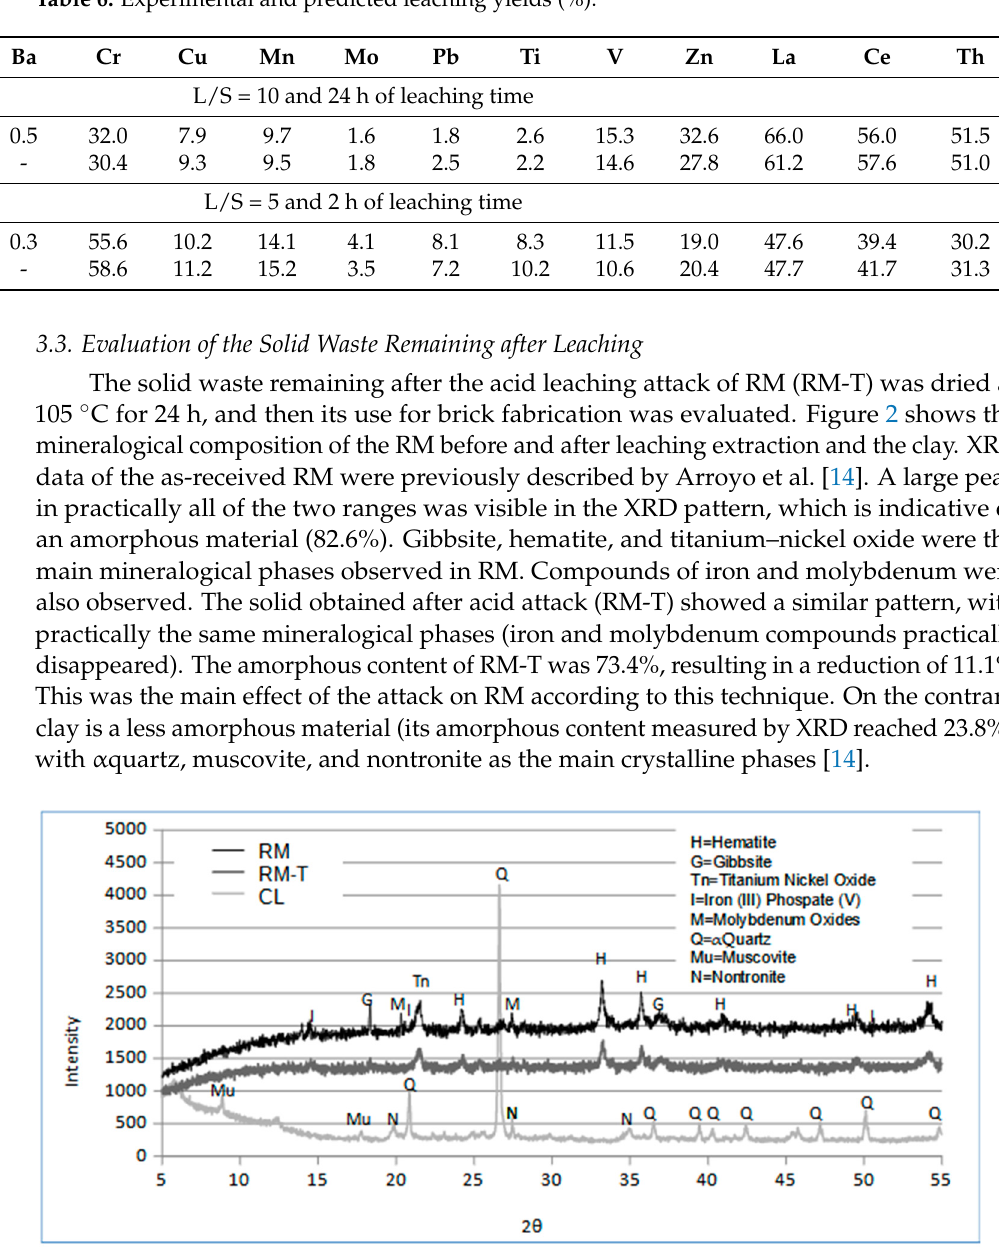
Table 6. Experimental and predicted leaching yields (%).